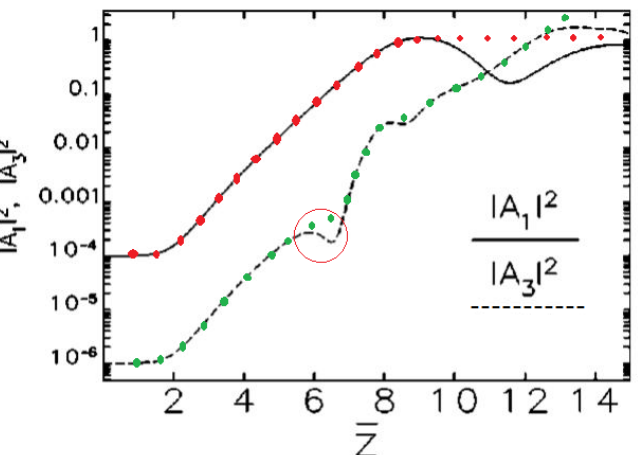
Figure 4. Growth of the first harmonic and of the higher-order self-injected contributions (courtesy of McNeil, Robb and Poole). ¯ z and | A | 2 are normalized longitudinal coordinate and field intensity respectively, the subscript 1,3 denote the harmonic order. The encircled region marks the transition between linear and NLHG, with a characteristic oscillation. The red and green dots refer to the semi-analytical